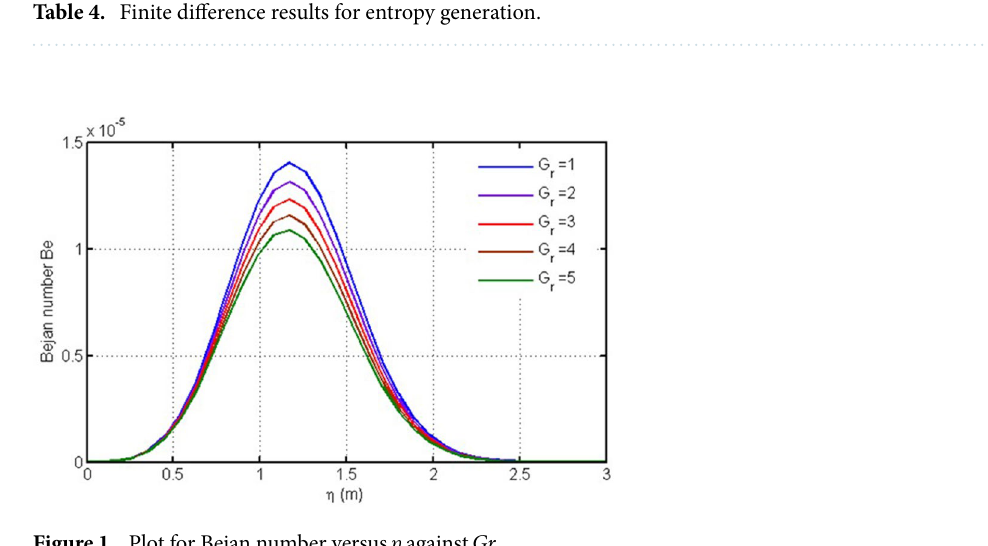
Figure 1. Plot for Bejan number versus η against Gr